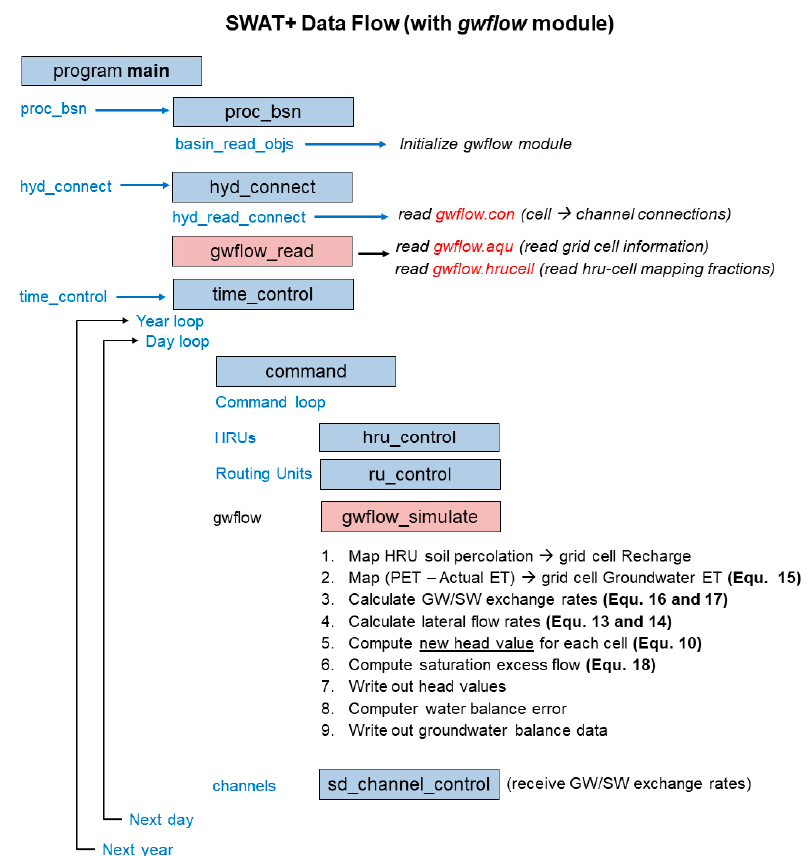
Figure 3. Data flow of the Soil and Water Assessment Tool + (SWAT + ) modeling code. Subroutines for the new gwflow module are shaded in light red, input files for the gwflow module are highlighted in red text, and the calculations performed in the gwflow module are listed in bullet points for the gwflow_simulate subroutine.